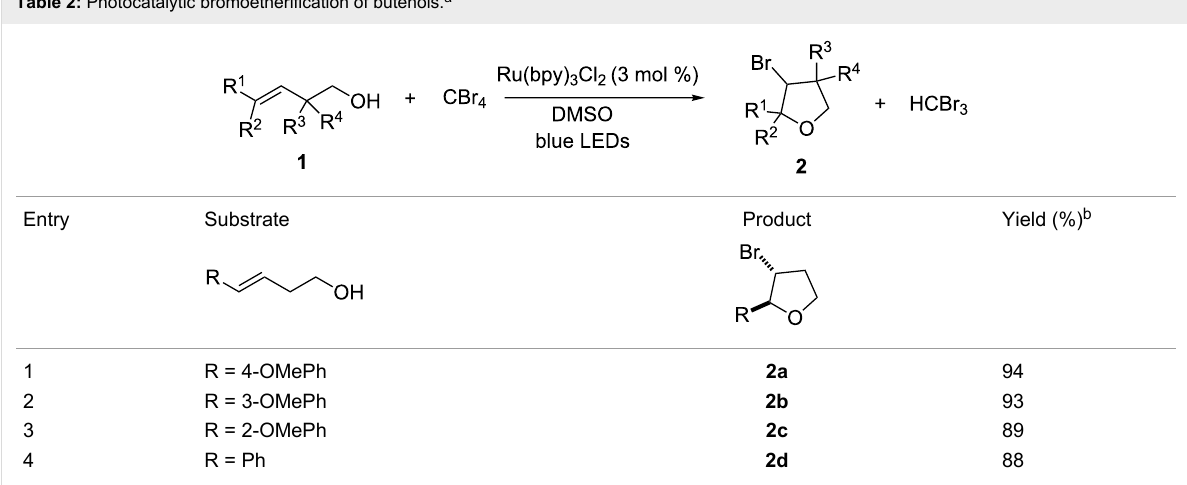
Table 2: Photocatalytic bromoetherification of butenols.